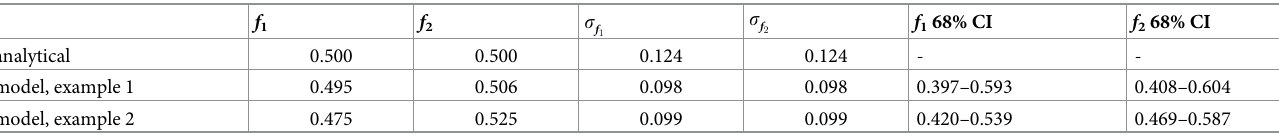
Table 2. Model outputs for the mixing case study defined in Table 1.